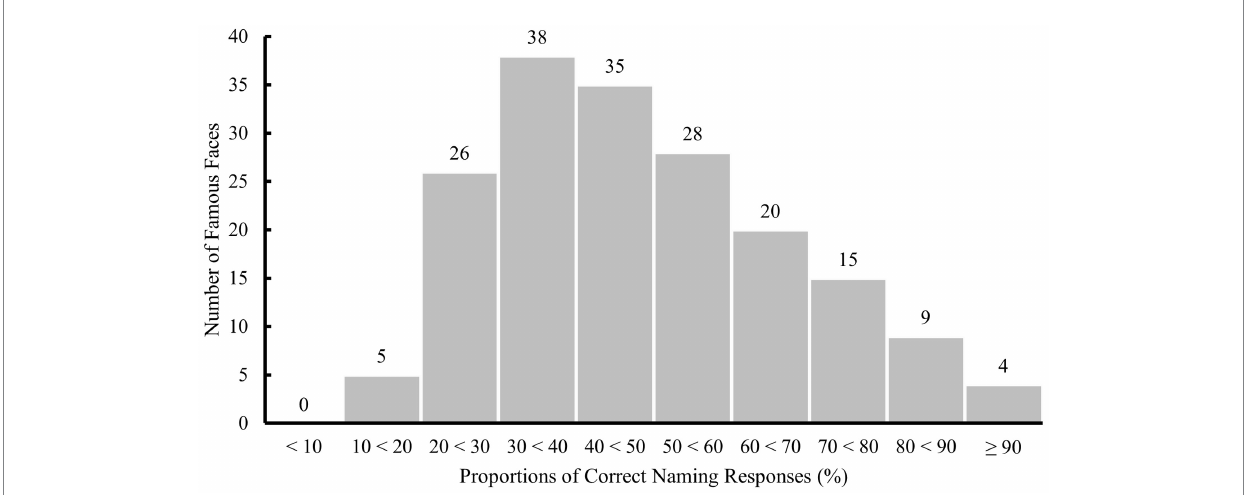
FIGURE 7 Distribution of proportions of correct naming responses to the 180 famous faces included in nine D-FFT versions in step 5 (excluding trial items and removed version). Labels on top of each bar indicate the number of famous faces per